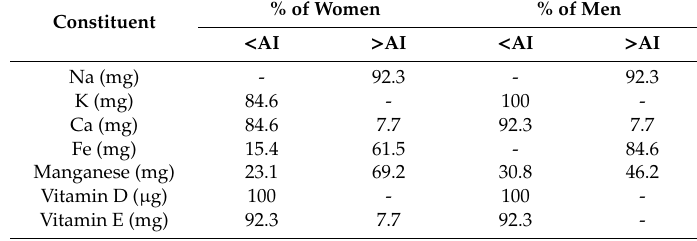
C. The percentage of men and women with reference to nutritional norms.